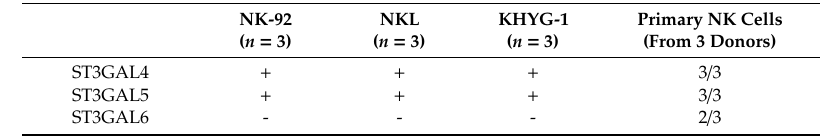
Table 2. Expression of sialyltransferases in human NK cells.